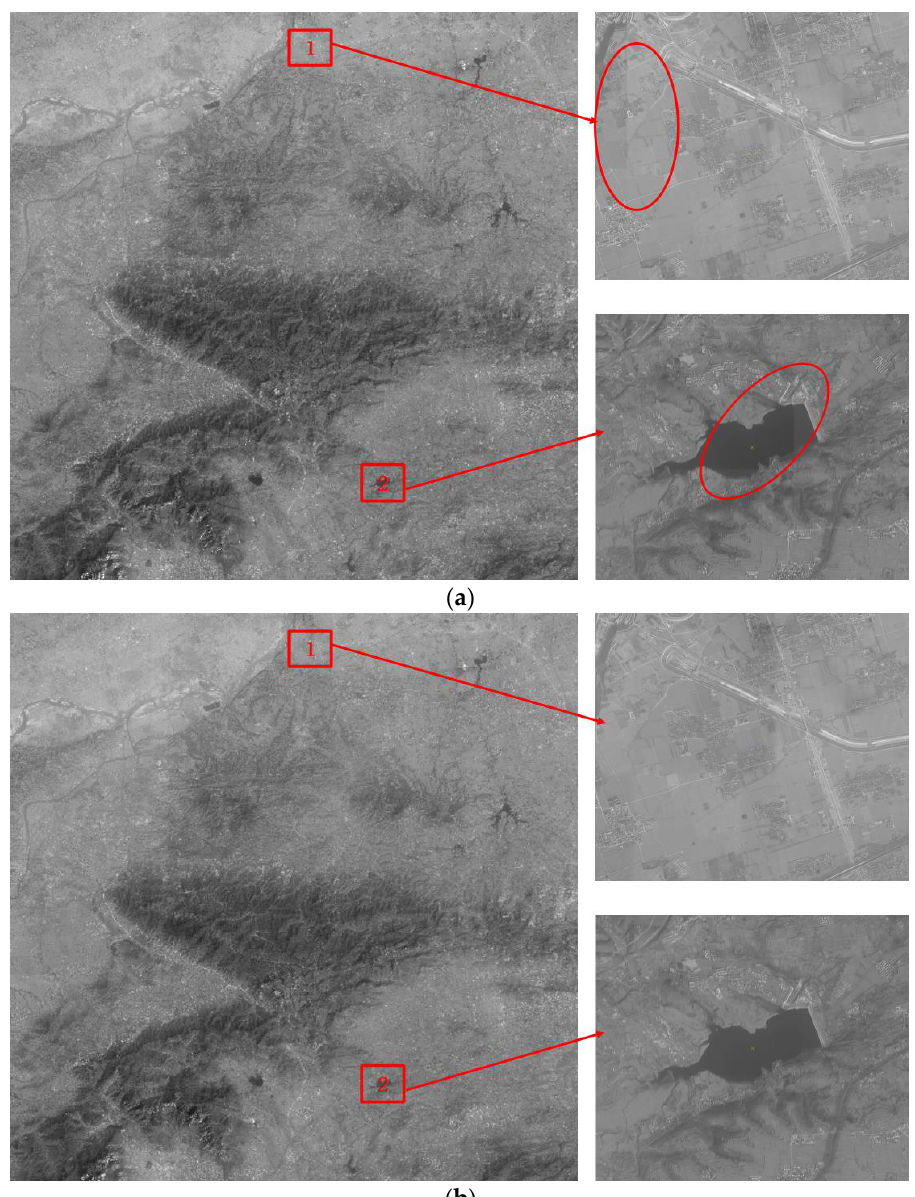
Figure 14. Final results: ( a ) mosaicking result without seam elimination and its local amplification effect on the images after image dodging by the improved method and ( b ) final mosaicking result with seam elimination and its local amplification effect of the images after image dodging by the improved method.